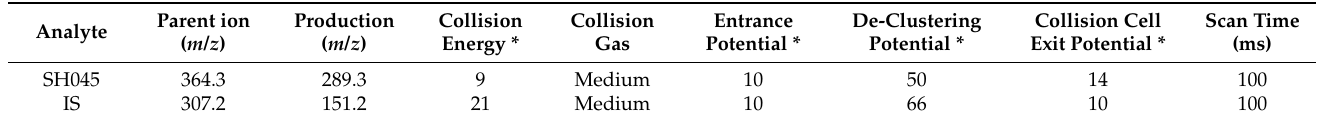
Table 1. Optimized conditions for detection of SH045 and IS by MRM in positive ESI mode (* arbitrary units).